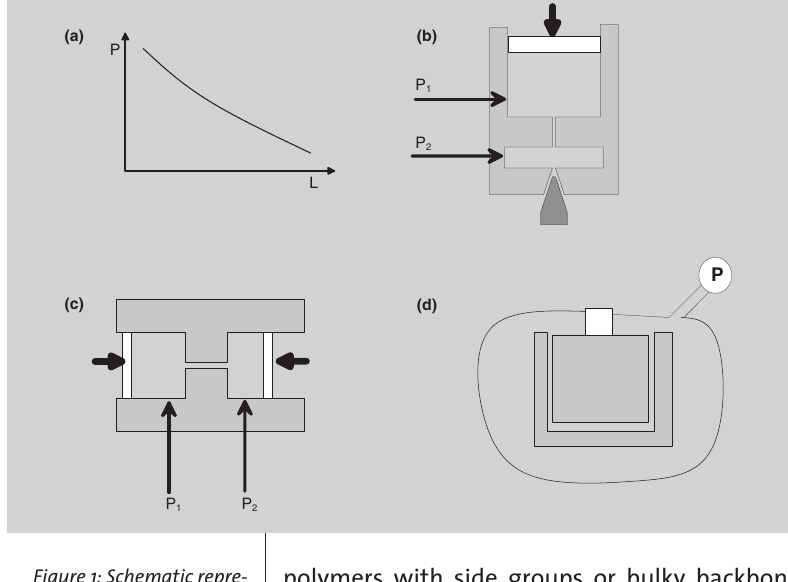
Figure 1: Schematic repre- sentation of the different methods to determine the effect of pressure on the viscosity : (a) non-linear pressure pro- files : P(L), (b) enhanced exit pressure devices (c) pressurized capillaries (d) pressurized drag flow